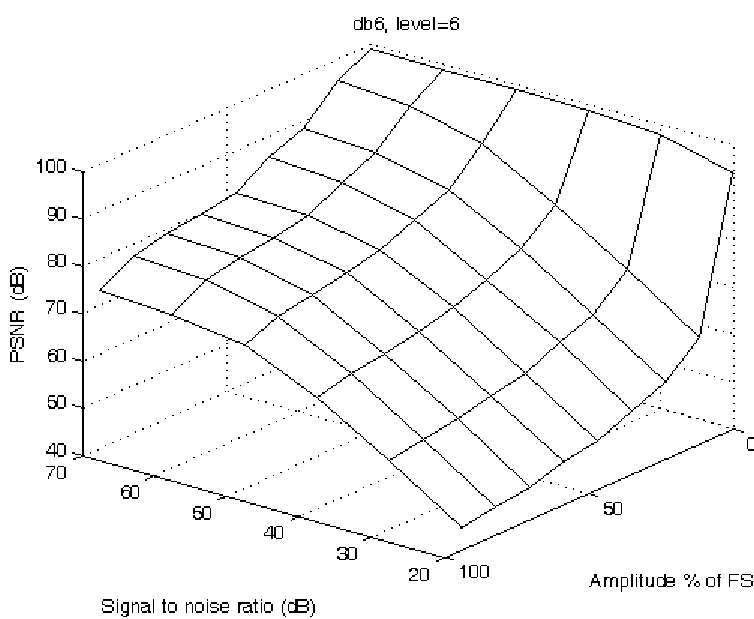
Figure 14. Result of PSNR analysis for changing SNR, and amplitude of generated signal.